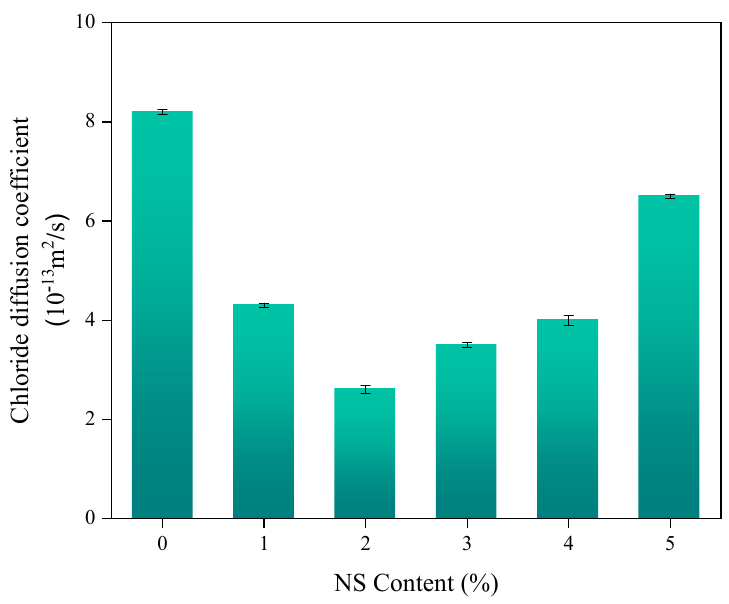
Figure 11. The influence of NS content on the chloride diffusion coefficient of concrete.